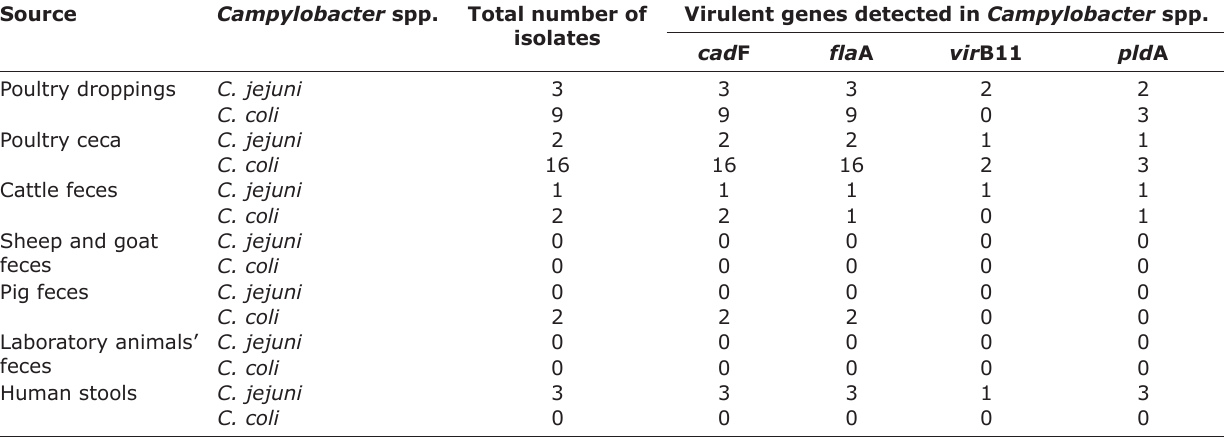
Table-3: Distribution of virulent genes among the Campylobacter